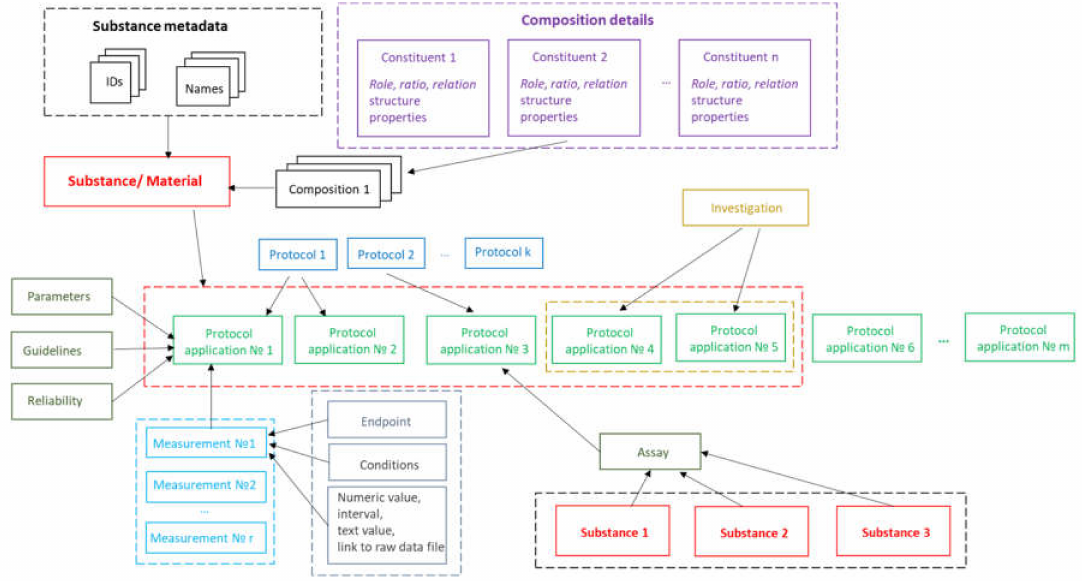
Figure 2. eNanoMapper / Ambit data